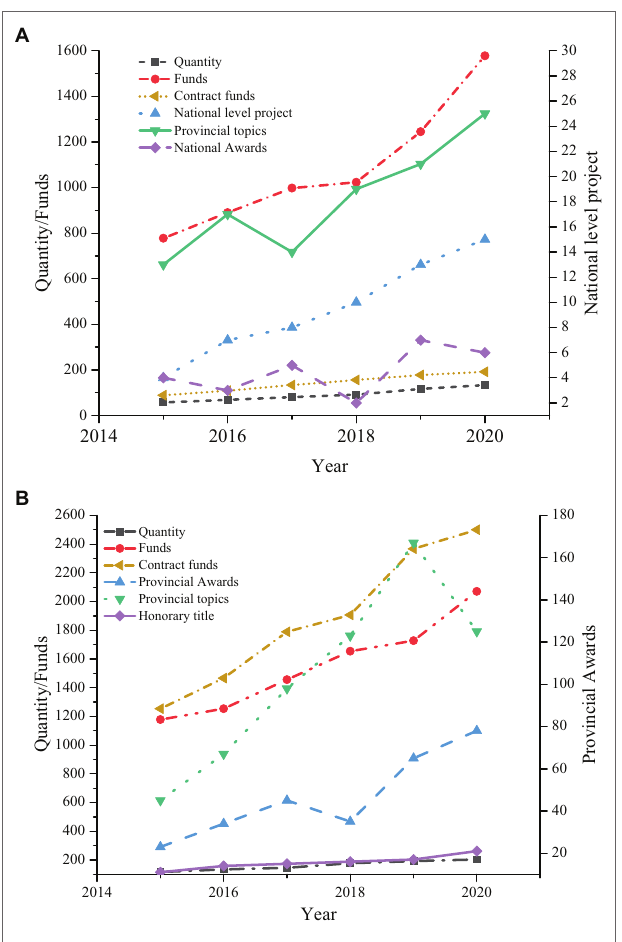
FIGURE 12 | Research funds and projects. (A) Projects in science and engineering and (B) horizontal projects.